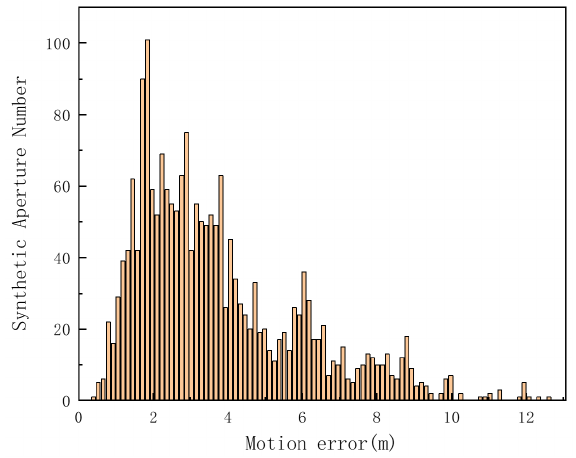
Figure 7. Subaperture motion error statistics.